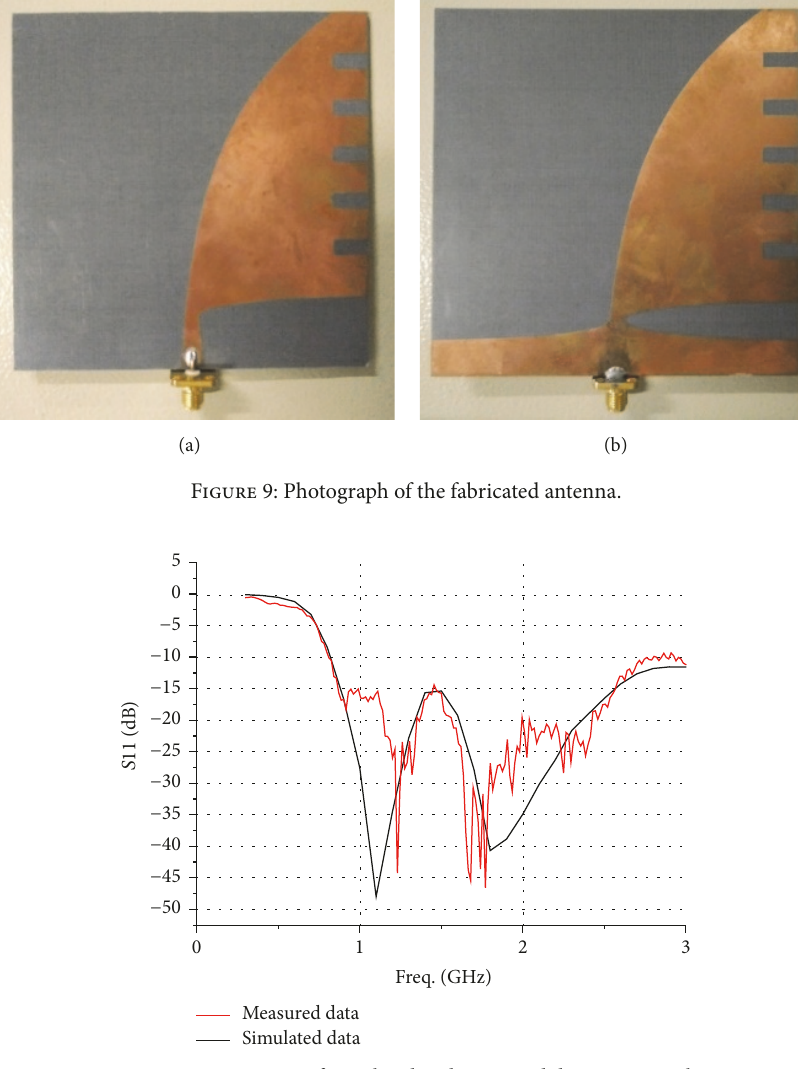
Figure 10: Comparison of simulated and measured data on return